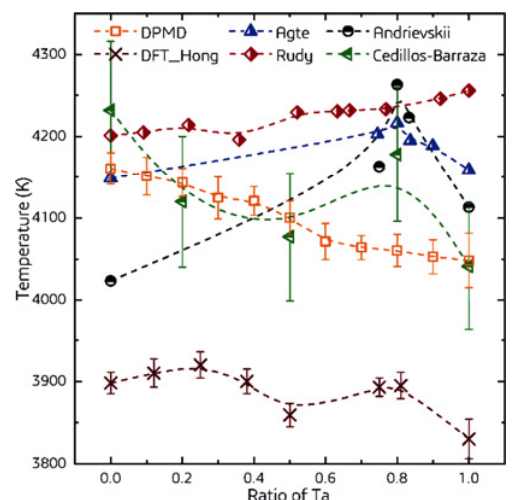
Fig. 5 Comparison of calculated and measured melting points of Hf 1 − y Ta y C 1 − x . DPMD represents results of Hf 1 − y Ta y C 0.88 calculated in this work. DFT_Hong means the results calculated by Hong and van de Walle [20] using DFT. Agte, Rudy, Andrievskii, and Cedillos-Barraza are the experimental results by Agte and Alterthum [13], Rudy and Harmon [16–18], Andrievskii et al . [14], and Cedillos-Barraza et al . [15],